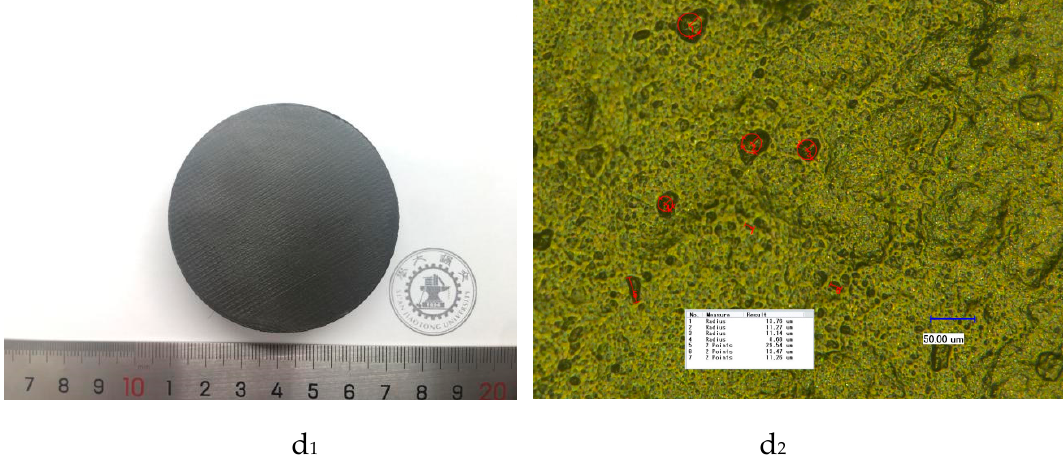
Figure 2. Surface structure diagrams of 3D printing (FDM) test pieces. ( a 1 ) and ( b 1 ) Unqualified test pieces. ( c 1 ) and ( d 1 ) Qualified test pieces. ( a 2 ), ( b 2 ), ( c 2 ), and ( d 2 ) Light microscopic images corresponding to ( a 1 ), ( b 1 ), ( c 1 ), and ( d 1 ), respectively.